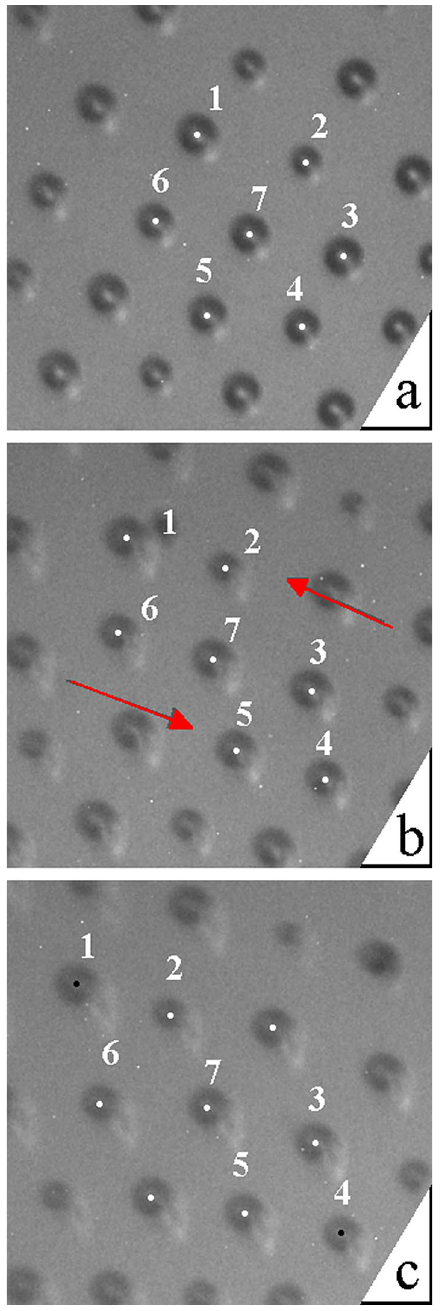
Figure 5. Hexagonal ordering is exhibited by droplets in the smectic film at certain moments of time. The droplets denoted 1, 2 and 4, 5 move in opposite directions relative to the row of droplets 3, 6, and 7. Hexagonal ordering ( a ) is destroyed ( b ) and then reconstructed after some time ( c ). Frame ( b ) is taken 55 s after frame ( a ), and frame ( c ) 40 s later. The horizontal size of the images is 191